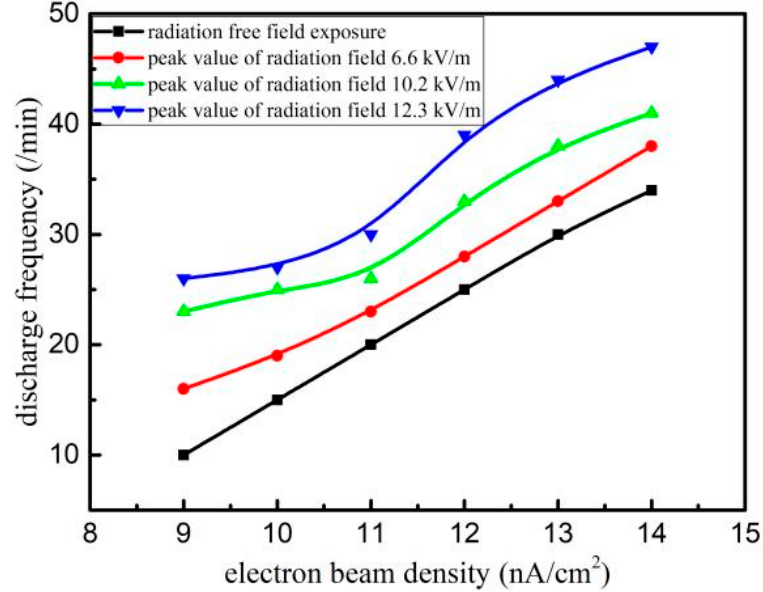
Figure 11. Trend of discharge frequency of battery array with electron beam density.